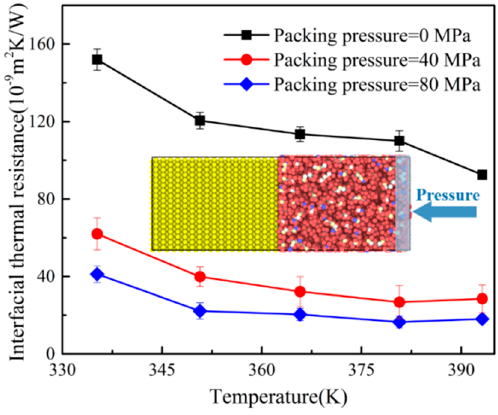
Figure 5. Variations of ITR at the different packing pressures. The inset depicts the PP-Ni system of the applying pressure.